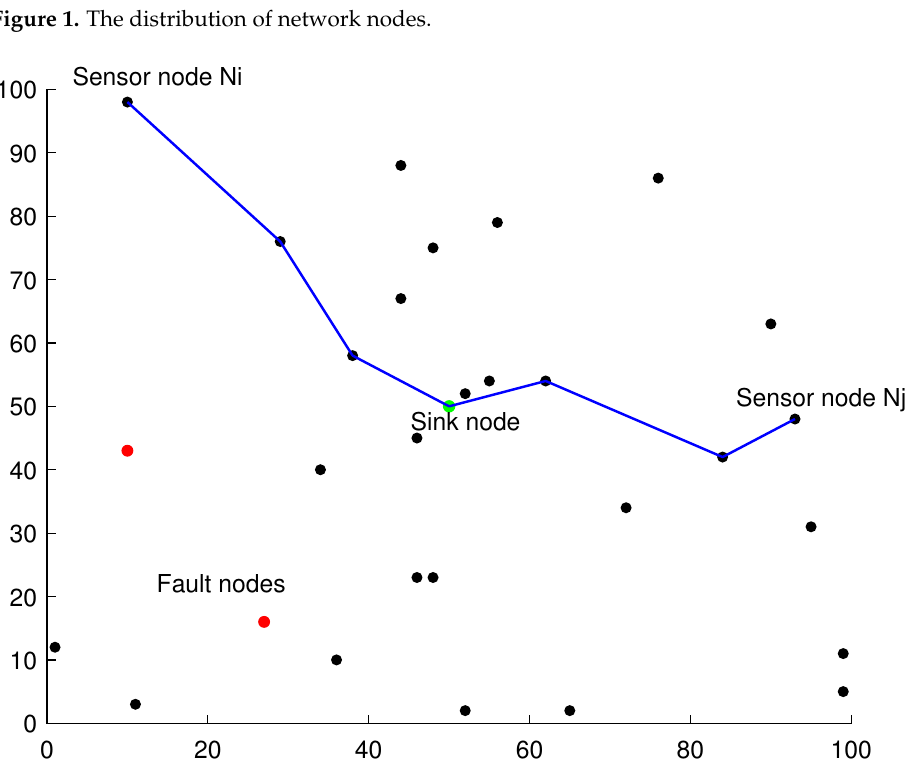
Figure 1. The distribution of network nodes.